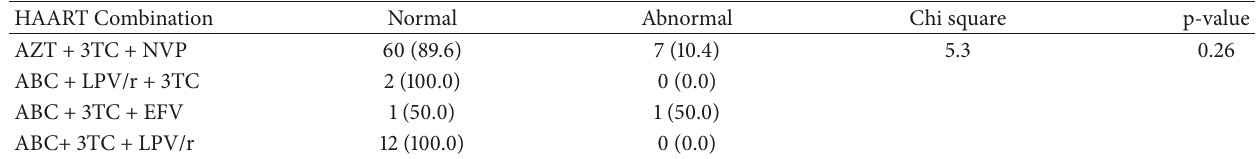
Table 4: Association between thyroid function and HAART